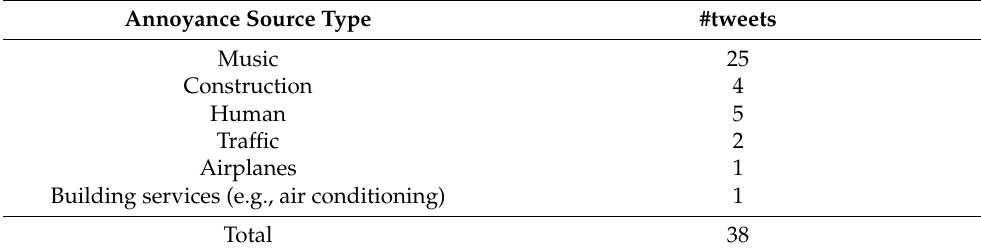
Table 4. Types of annoying noises reported by Twitter—UAE 2015.